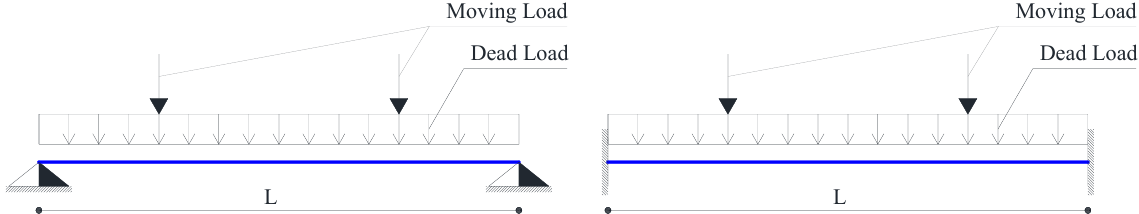
Figure 4. Di ff erent constraint conditions for the secondary beams.